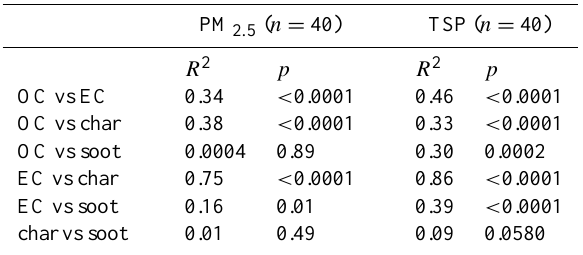
Table 5. Relationships among carbonaceous species in PM 2 . 5 and